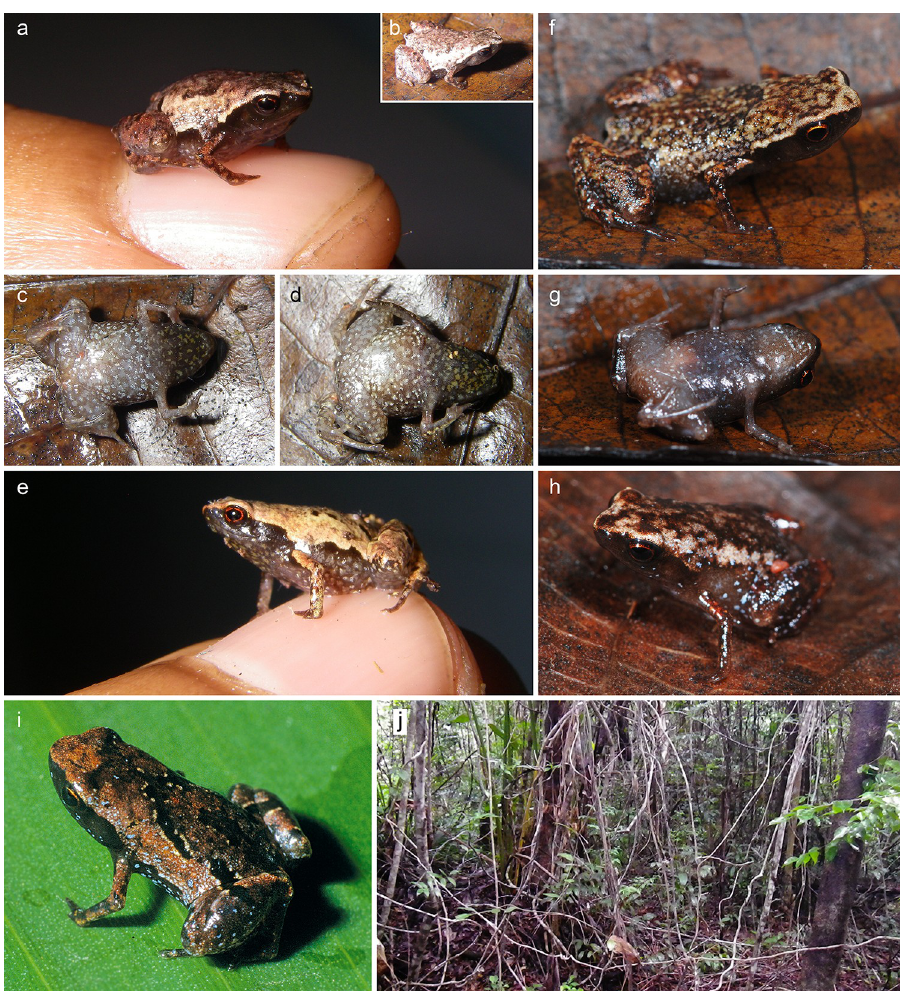
Fig 4. Mini mum gen. et sp. nov. in life and its habitat in Manombo Special Reserve. (a-c) ZSM 861/2014, holotype, in (a) anterolateral view on a thumbnail, (b) dorsolateral view on a leaf, (c) ventral view. (d, e) ZSM 862/2014, paratype, in (d) ventral view, and (e) lateral view on a thumbnail. (f, g) ZMB 83194, paratype, in (f) dorsolateral view, and (g) ventral view. (h) ZMB 81993, paratype, in dorsolateral view. (i) ZMA 20172 in posterodorsolateral view. (j) Habitat of the new species in Manombo Special